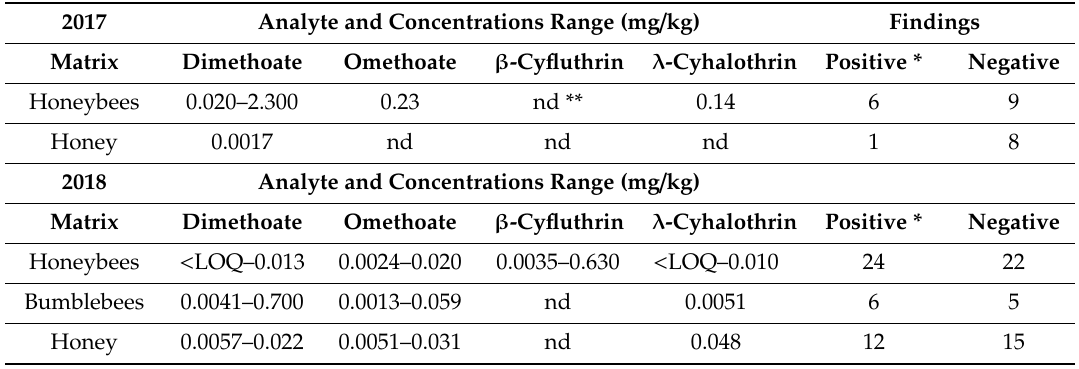
Pesticides and concentration ranges in 2017 and 2018 honeybees, bumblebees and honey samples. samples.